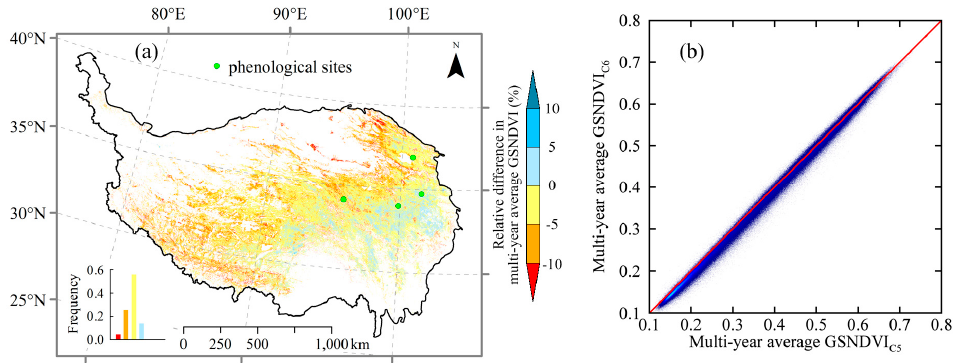
Figure 2. ( a ) The relative difference in the multi-year average growing season Normalized Difference Vegetation Index between C6 (GSNDVI C6 ) and C5 (GSNDVI C5 ) ((C6–C5)/C5) during 2001–2015; ( b ) The scatter plot of the multi-year average GSNDVI C6 against GSNDVI C5 during 2001–2015.